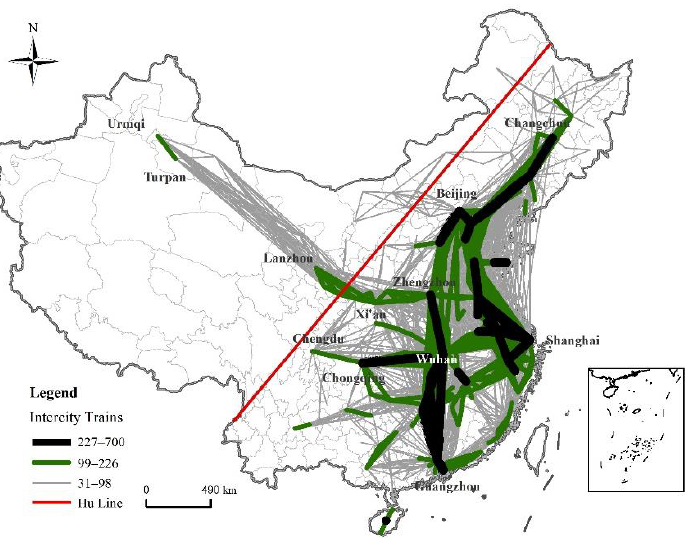
Figure 4. Intercity train network (for clarity, the figure omits intercity links with strength scores less than or equal to 30). than or equal to